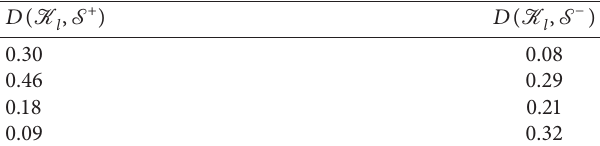
Table 4: Distance of alternatives from FFPIS and